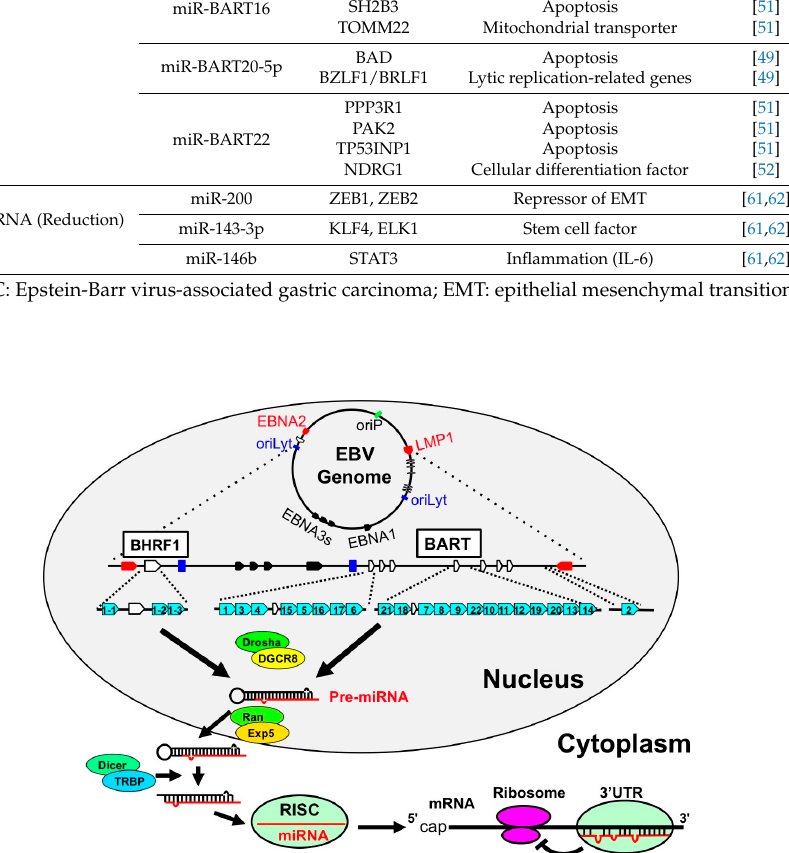
Figure 3. The genomic location of EBV-encoded miRNAs. In latently-infected cells, the EBV genome exists in the nucleus as a circular episome. The starting sites of viral replication are indicated as a green box (origin of plasmid replication; oriP) and blue boxes (origins of lytic replication; oriLyt). The coding regions of the latent membrane protein 1 (LMP1) and EBNA2 are indicated as red arrows. These are transcribed in antisense and sense orientations, respectively. EBNA3s and EBNA1 are indicated as black arrows. With regard to the BHRF miRNAs, BHRF1 ORF is encompassed with one 5 ′ -end and two 3 ′ -end miRNAs (light blue arrows). BART miRNAs are located in the intron region of noncoding RNA BART and are indicated as blue arrows. The white arrows indicate the BHRF and BART exons. (1) Drosha processing: pri-miRNAs are processed by Drosha-DGCR8 complex to become pre-miRNAs. (2) Pre-miRNA transport: pre-miRNAs are then transferred from the nucleus to the cytoplasm by Exportin5-RanGTP8 complex. (3) Dicer processing: pre-miRNAs are digested by Dicer-TRBP complex and miRNAs are generated. (4) RISC loading and translational inhibition: and miRNAs are incorporated into RNA-induced silencing complex (RISC) and specifically inhibit the translation of the targeted